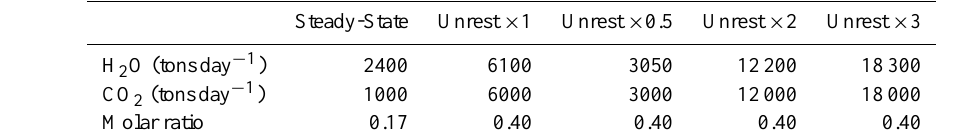
Table 4. Injection rates (tonsday − 1 ) for different unrest simulations. Molar ratio is 0.17 for the Steady-State simulation and 0.40 for all the Unrest simulations.